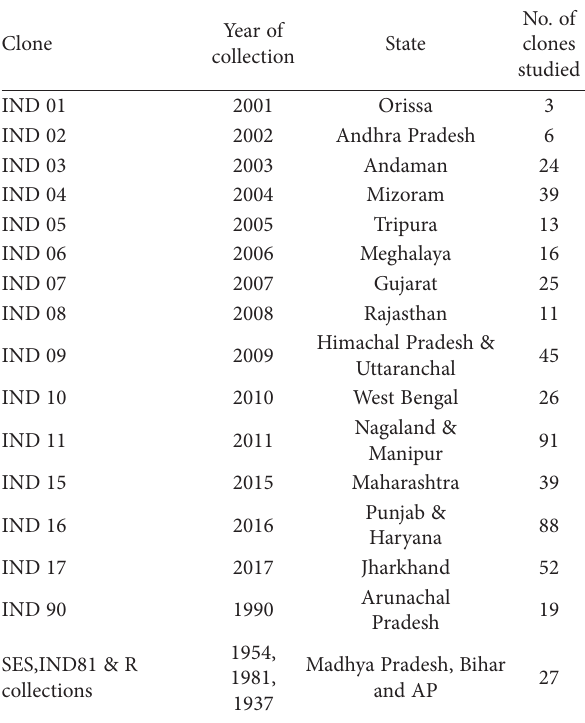
Table 1. Details of S. spontaneum clones cytologically analyzed.